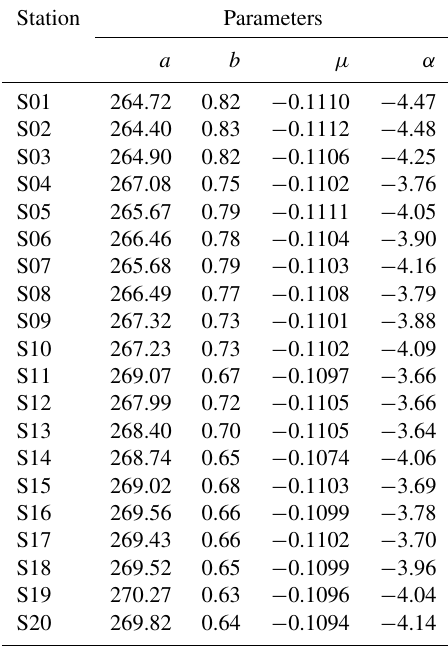
Table 1. Estimated values of a , b , µ and α for the 20 synoptic sites using ERA-I atmospheric profiles over the whole year of 2014.